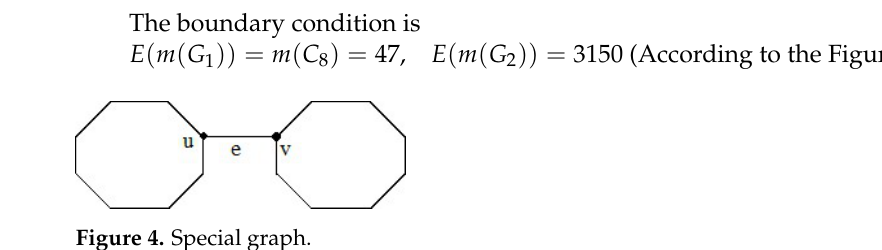
Figure 4. Special